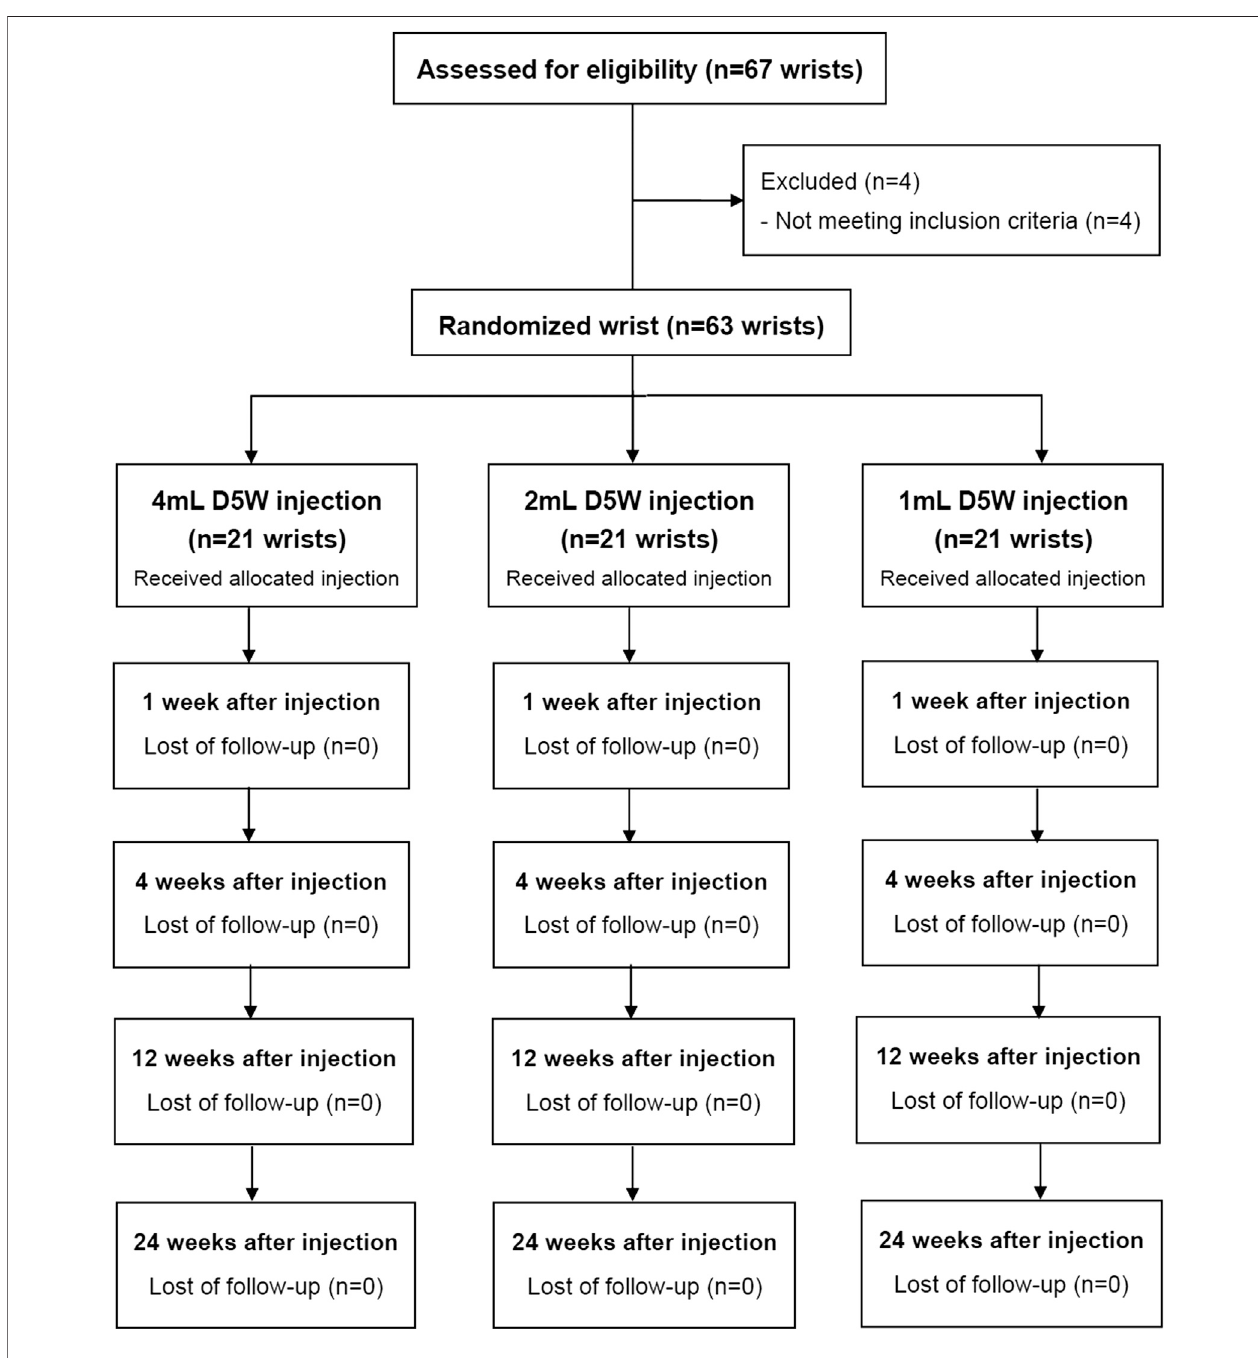
FIGURE 1 | Study fl ow diagram. D5W, 5% dextrose